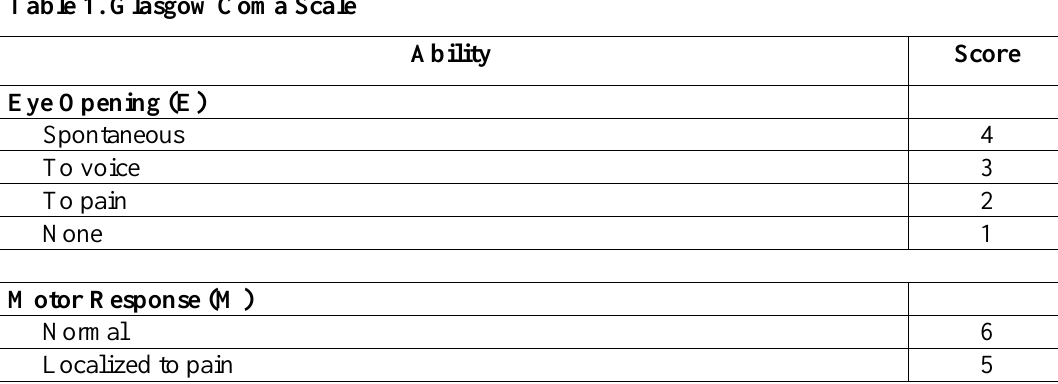
Table 1. Glasgow Coma